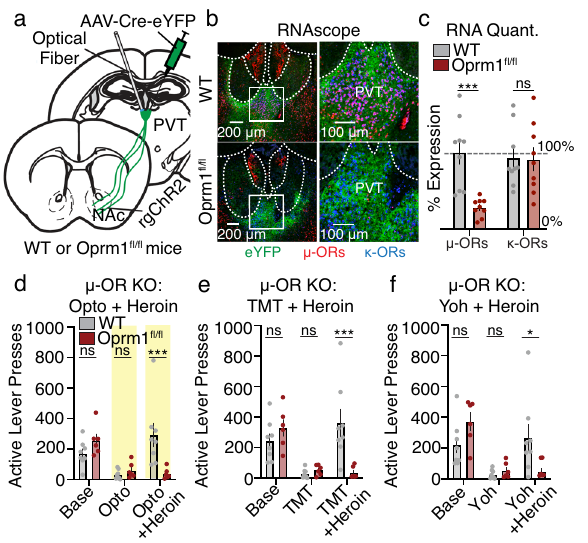
Fig. 5 | Selective knockout of PVT µ -opioid receptors prevents heroin-induced behavioral disinhibition. a Surgical strategy for PVT µ -OR knockout with simul- taneous optogenetic manipulation of PVT → NAc neurons. b Example images showing RNAscope in situ hybridization of PVT µ -ORs and κ -ORs in WT (top) and Oprm1 fl / fl (bottom) mice. c Quanti fi cation reveals reduced µ -OR but not κ -OR RNA expression in Oprm1 fl / fl mice ( n =3 Oprm1 fl / fl , 2 WT mice; two-way ANOVA, group x receptor interaction: F 1,32 =7.61, P =0.01; Sidak ’ s post-hoc: P =0.001). d – f Knockout of PVT µ -ORs in Oprm1 fl / fl mice rescued the suppression of sucrose self-administration caused by optogenetic stimulation of PVT → NAc neurons ( d ), TMT ( e ),and yohimbine ( f ) despite systemic heroin injection ( n =6 – 8 mice/group; Opto: n =6 Oprm1 fl / fl , 8 WT mice; repeated-measures two-way ANOVA, group × day interaction: F 2,24 =8.33, P =0.002; Sidak ’ s post-hoc: opto + heroin P =0.001; TMT: n =6 Oprm1 fl / fl , 8 WT mice; repeated-measures two-way ANOVA, group × day interaction: F 2,24 =8.94, P =0.001; Sidak ’ s post-hoc: TMT+heroin P =0.001; yohimbine: n =6 Oprm1 fl / fl ,8WTmice;repeated-measurestwo-wayANOVA,group× dayinteraction: F 2,24 =5.53, P =0.01;Sidak ’ spost-hoc:TMT+heroin P =0.02). µ -OR µ -opioid receptor, κ -OR κ -opioid receptor, Base Baseline, Opto optogenetics, Yoh Yohimbine. Group comparisons: * P <0.05, ** P <0.01, *** P =0.001. Bar graphs are presented as mean values±SEM. Source data are provided as a Source Data fi